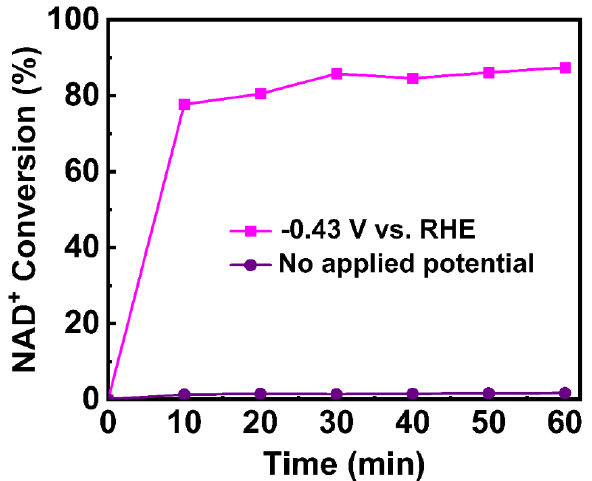
Figure 3. NAD + conversion by the Rh-complex fixed electrode with or without the applied potential. 2.3. Bio-Electrocatalysis Production of Furfural Alcohol from Furfural